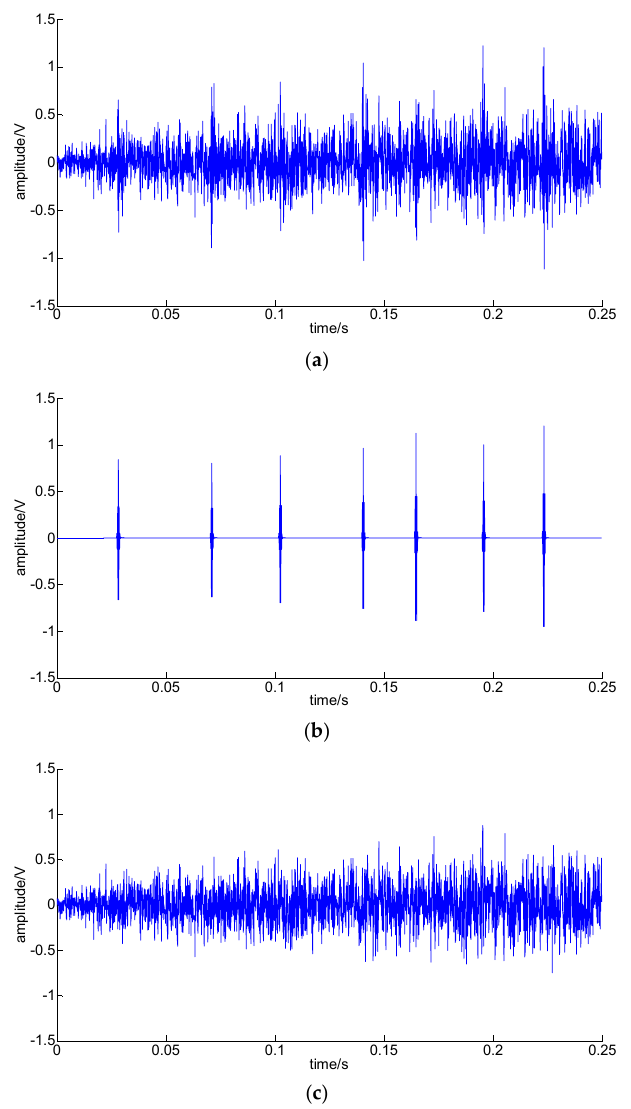
Figure 10. The outer ‐ ring fault bearing. Table 7. Bearing parameters.